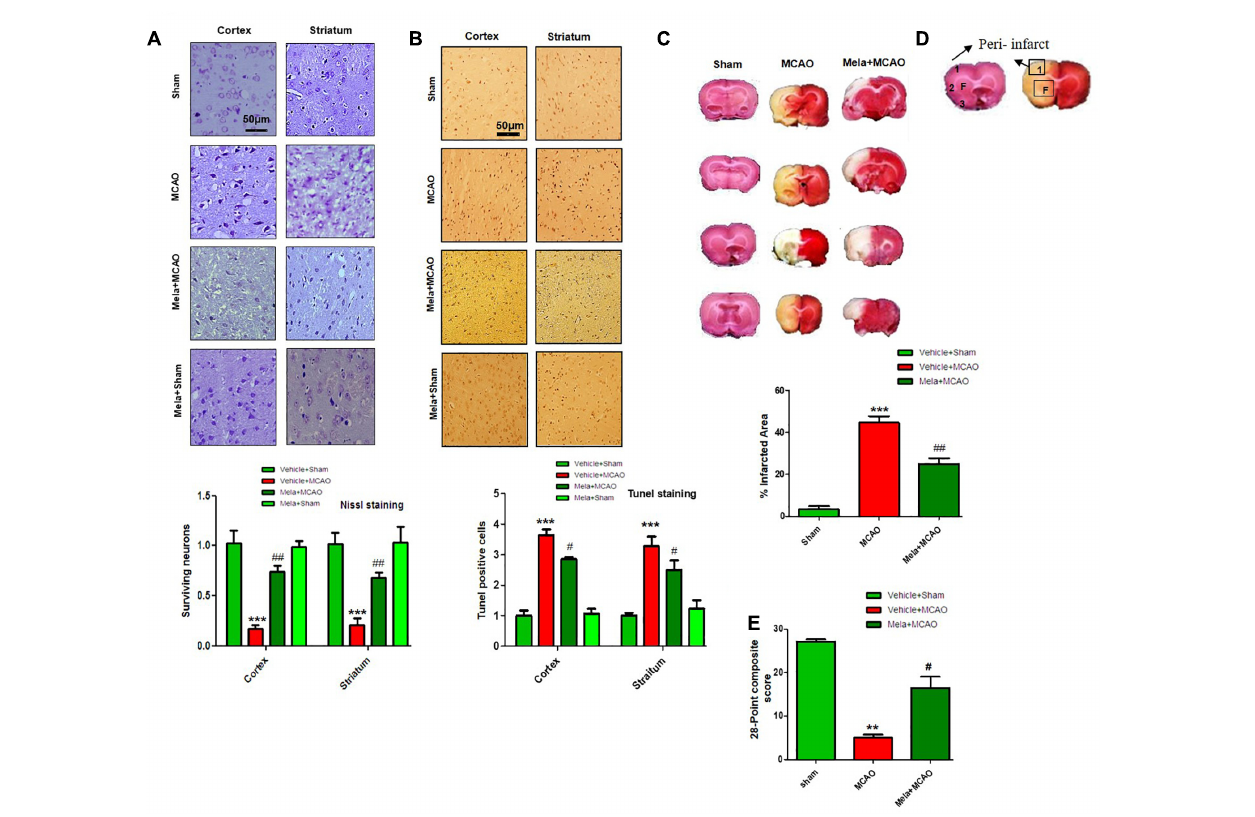
FIGURE 1 | Effect of melatonin on neurological scores, brain infarction and neurodegeneration. (A) Effect of melatonin on Nissl staining. Representative photomicrograph of cresyl staining showing the extent of surviving neurons in cortex and striatum; ( n = 7 animals/group). The number of experiments performed = 3 and data presented is relative to sham. Magnification 20 × , scale bar = 50 µ m. (B) Tunel histochemistry with representative photos showed apoptotic cells (scale bar = 50 µ m, magnification 20 × ). Images are representative of experiments performed 3 times with n = 7 per group. MCAO causes significant neuronal apoptosis; while treatment with melatonin attenuated apoptotic damage. (C) Brain coronal sections were stained with TTC, which distinguishes between ischemic and non-ischemic areas. Student’s t -test was used for analysis, ( n = 7/group. ∗∗∗ indicates p < 0.001, while symbols ∗∗ and ## represent p < 0.01 significantly different; # indicates p < 0.05. Symbols ∗ shows significant difference relative to sham control while # shows significant difference relative to MCAO. (D) Coronal sections separated by frontal cortex (1), parietal cortex and insular cortex (2), and periform cortex (3). The analyzed region of interests indicated by square 1 and F. (E) 28 points composite scoring. Mela+MCAO rats had significantly less severe neurological deficits ( # p < 0.05) than MCAO rats had. Mann-Whitney (non-parametric test) is applied and neurological score data is presented as the median and range ( n =